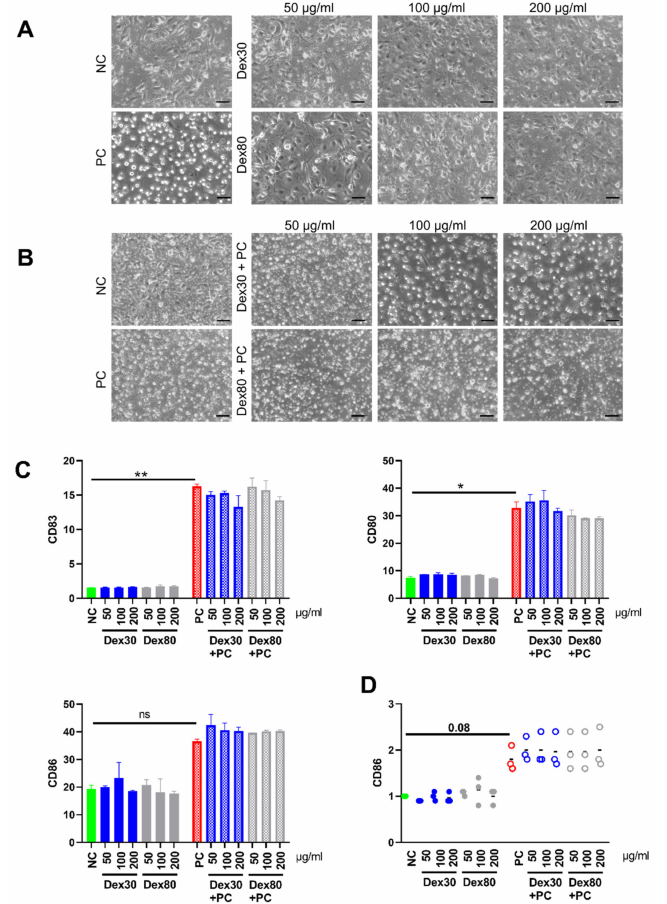
Figure 4. The effect of 30 nm and 80 nm SPION Dex on the maturation of DCs. Immature DCS were incubated with SPION Dex in the absence or presence of a stimulation mix containing IL-1 β , IL-6, PGE and TNF- α (as positive control, PC) for 48 h. The experiment was performed with blood from three healthy donors and PBS served as negative control (NC). ( A , B ) Brightfield microscopy of ( A ) dendritic cells after 48 h incubation with SPION Dex , ( B ) dendritic cells after 48 h incubation with SPION Dex and stimulation mix. Scale bar refers to 200 µ m. ( C ) Flow cytometry of DC maturation markers CD80, CD83, and CD86 on DCS from one exemplary donor. ( D ) Merged data of the three donors. The negative control of each donor was set to 100, samples were calculated accordingly. The mean values for each donor are shown. Black line represents the mean values of all